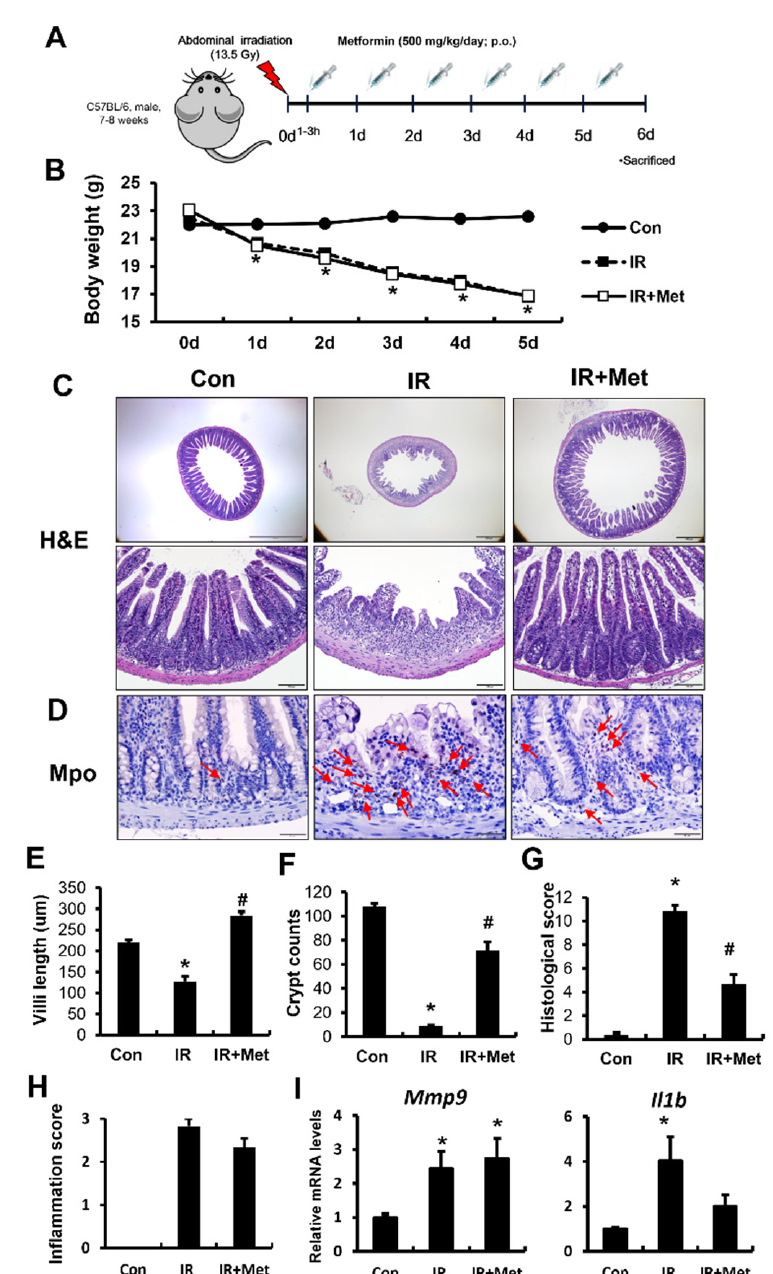
Figure 1. Metformin alleviated radiation-induced enteropathy and partially inhibited inflammation response in a mouse model. ( A ) Experimental schematic; ( B ) bodyweight; ( C ) hematoxylin–eosin (H&E) stain; ( D ) immunohistochemistry of myeloperoxidase (Mpo), a neutrophil marker; ( E ) villi length; ( F ) the number of crypt cells in the small intestine of control (Con), irradiated (IR), and metformin-treated IR (IR + Met) mice at 6 days. Bar = 50 µ m; ( G ) histological score assessed by the degree of maintenance of epithelial structure, crypt destruction, vascular dilation, and inflammatory-cell infiltration in the mucosa (0 = none, 1 = mild, 2 = moderate, 3 = high); ( H ) inflammation score; and ( I ) mRNA levels of matrix metallopeptidase 9 (Mmp9) and interleukin (IL)-1 β in the intestines from the Con, IR, and IR + Met groups. The red arrow indicates Mpo-positive neutrophils. Data are presented as the mean ± standard error of the mean; n = 6 mice per group. * p < 0.05 compared to the Con group; # p < 0.05 compared to the IR group.